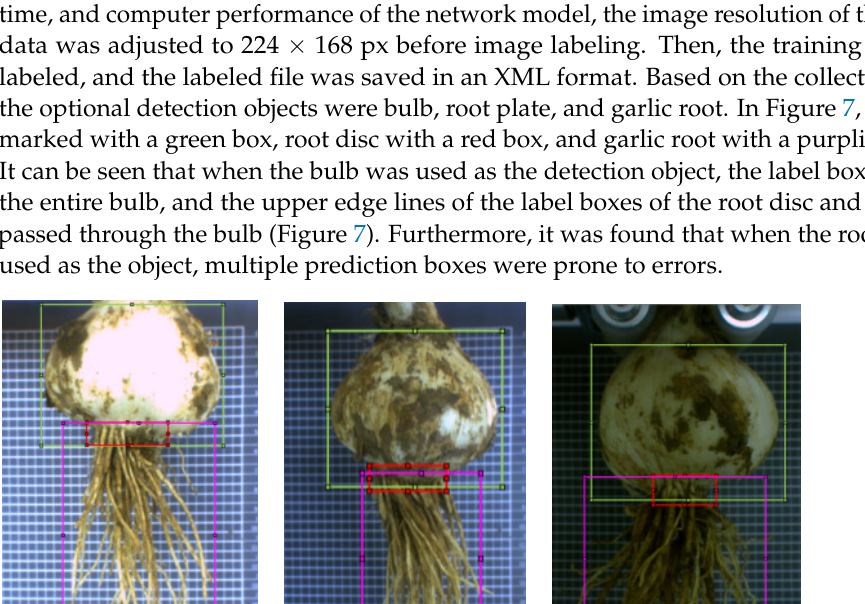
2.2.2. Partition of Datasets